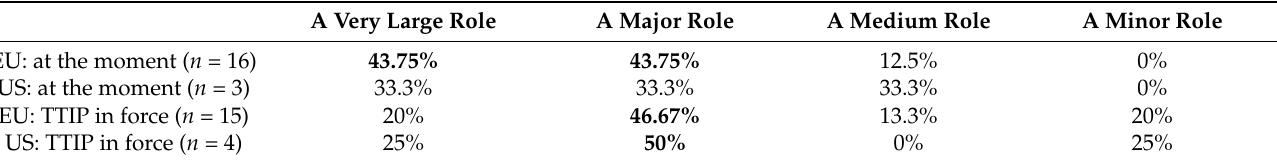
Table 6. Comparison of the EU and the US on the role of international quality standards in global trade during the TTIP process. A Very Large Role A Major Role A Medium Role A Minor